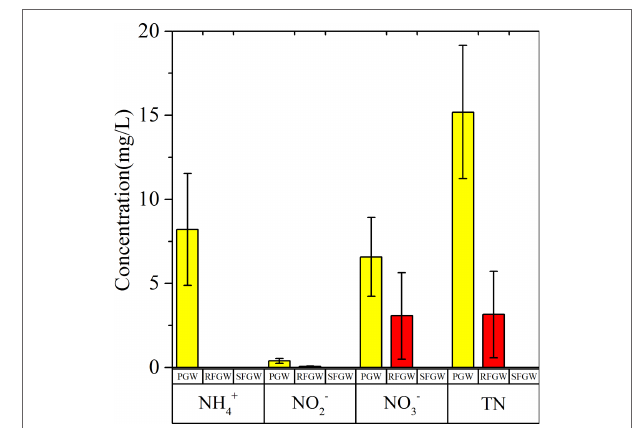
FIGURE 4 | Nitrogen variations in the groundwater of the study area.